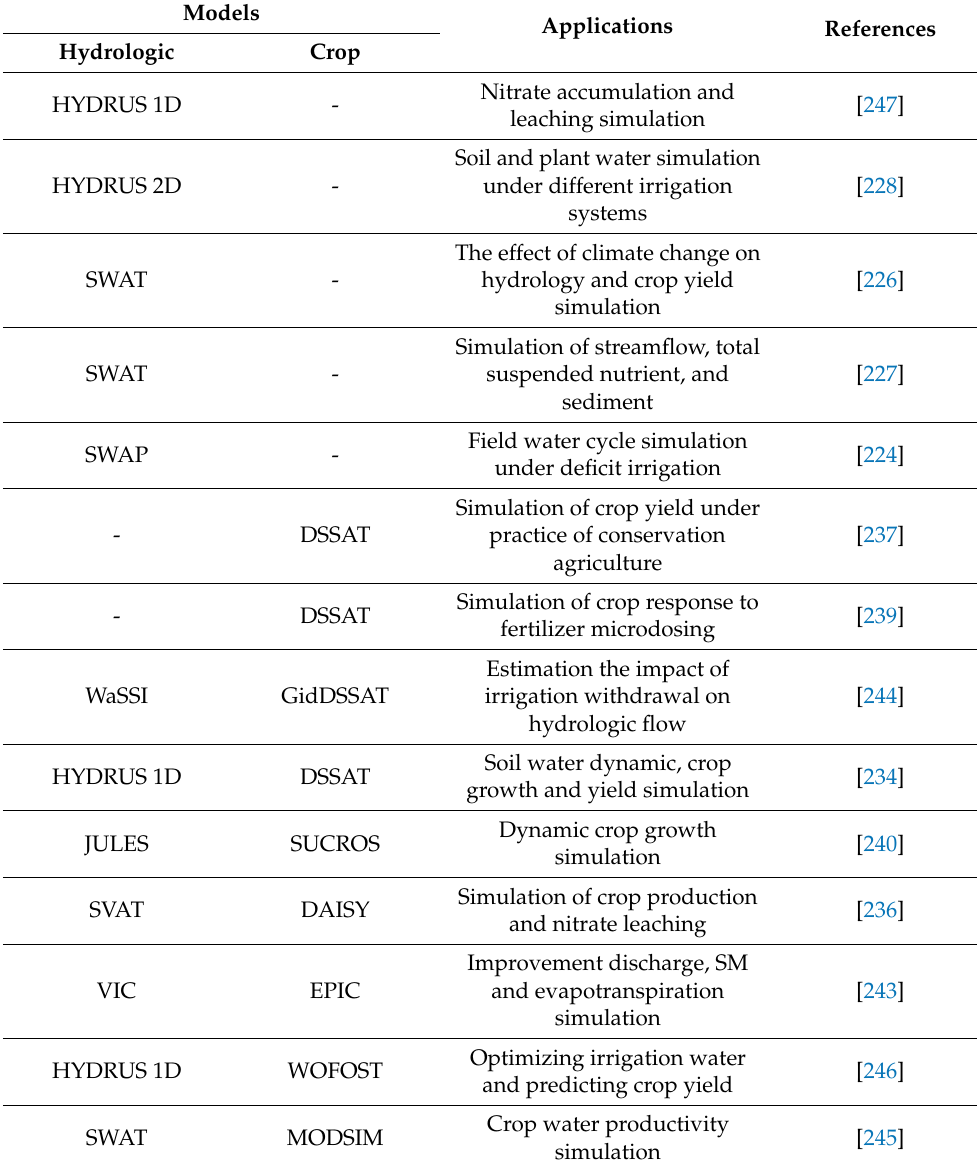
Table 5. Overview of different applications of hydrologic, crop, and coupled models for agricul- tural